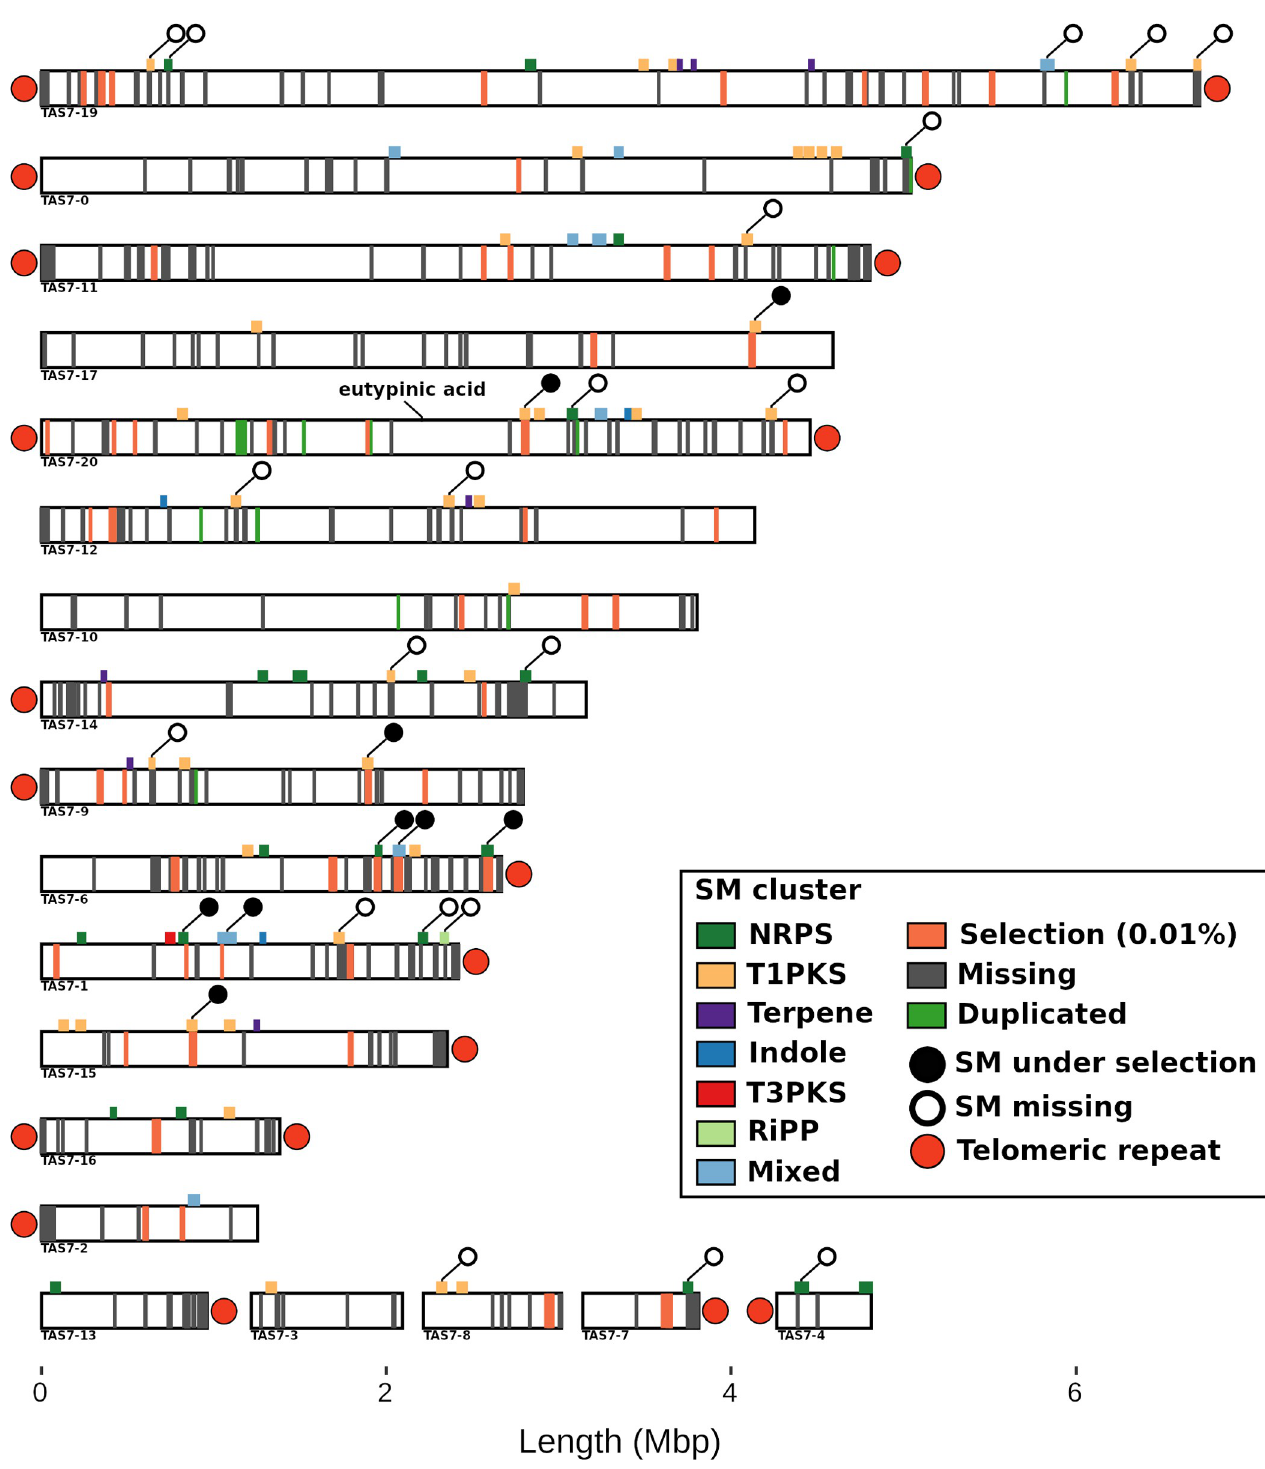
Fig 2. Karyotype representation of the genome assembly of Eutypa lata isolate TAS7. Predicted secondary metabolite (SM) clusters are shown above each contig with type of cluster indicated in the legend. Regions marked inside the contigs correspond to the following: (orange) top 0.01% μ scores representing signatures of selective sweep within the Australian population, (grey) missing genomic regions and (green) duplicated regions that overlap with CDSs present in at least one isolate. SM clusters under positive selection and missing in at least one sample are tagged with filled and empty circles, respectively. The genomic location of the previously reported eutypinic acid cluster [77] is